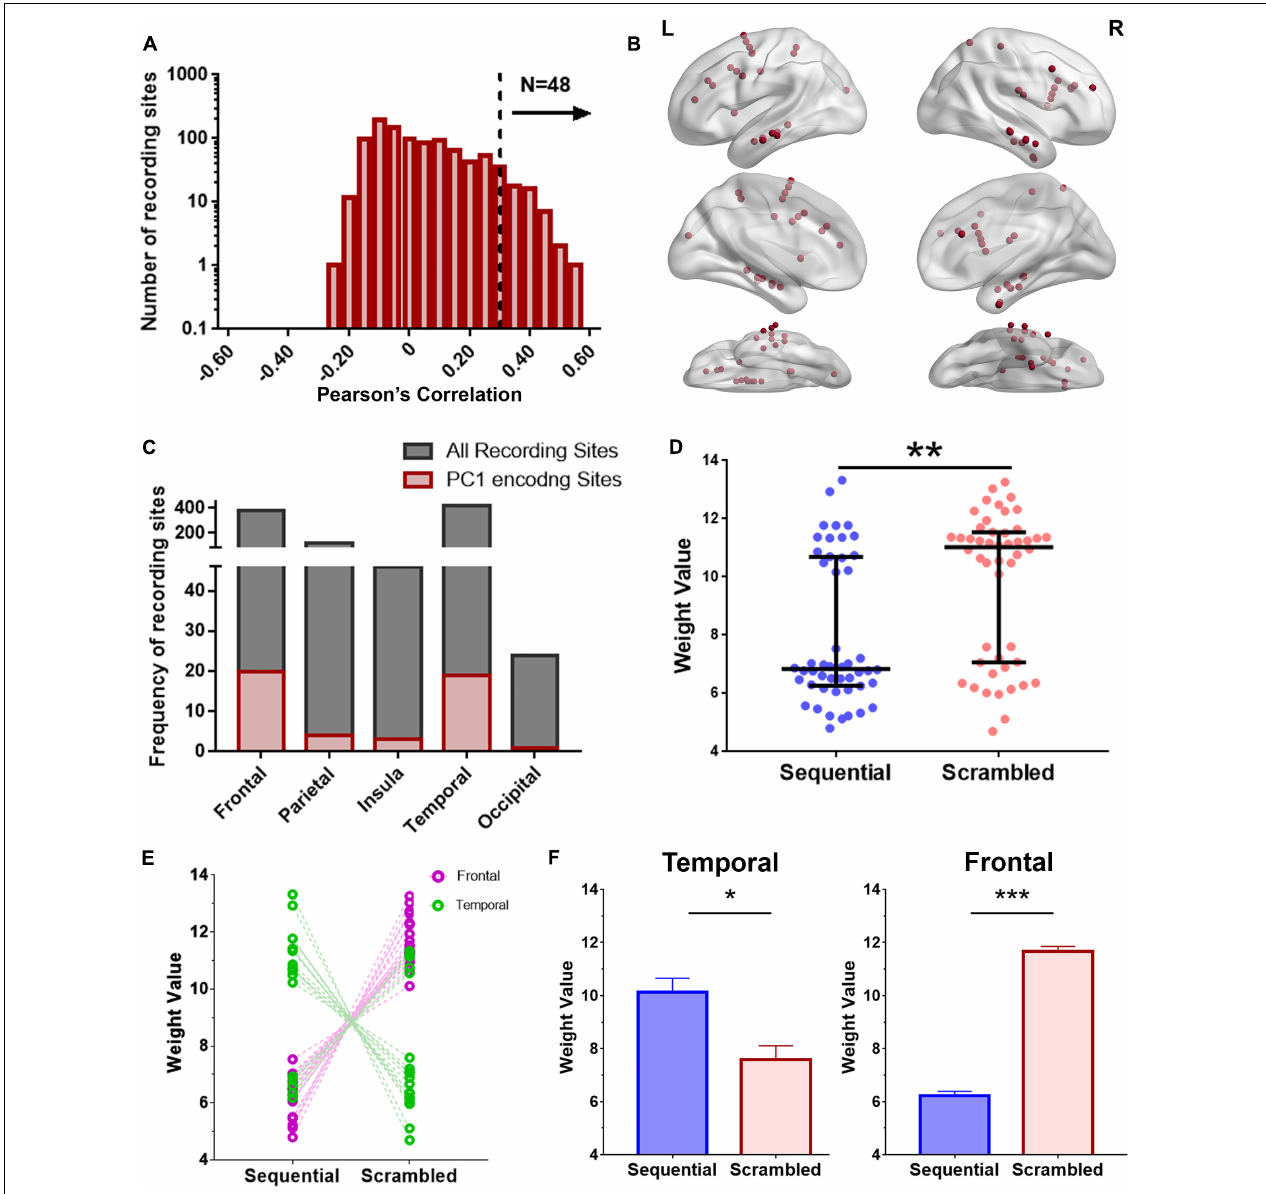
FIGURE 4 | Encoding model for examining regional broadband spectral differences in response to Seq and Scr experimental conditions. (A) Histogram of encoding prediction accuracy across all recording sites for PC1 which captures broadband spectral features. High encoding performance recording sites were defined as those with P < 0.05 on permutation test (dashed line, Pearson correlation > 0.34). (B) Distribution of high encoding performance recording sites (red dots) across all brain regions based on (A ; N = 48 recording sites). L , Left hemisphere; R , Right hemisphere. (C) Distribution of high encoding performance recording sites relative to the total recording sites from each brain region. (D) Predicted weights (PC1 projections) for Seq and Scr experimental conditions across the 48 encoding recording sites. Weights from Scr experimental conditions are significantly higher than those of Seq across all sites ( ∗∗ P < 0.01, Mann–Whitney test). (E, F) Predicted weights in (D) were grouped according to temporal vs. frontal locations and also by Seq vs. Scr experimental conditions. There is a significant decrease in temporal broadband power in response to Scr relative to Seq whereas there is a significant increase in frontal broadband power in response to Scr relative to Seq ( ∗ P < 0.05 ∗∗∗ P < 0.001, Mann–Whitney test). Refer to Supplementary Figure 4 for additional details of the encoding recording sites across subjects, and to Supplementary Figure 5A for further comparison of (D) with ISI.